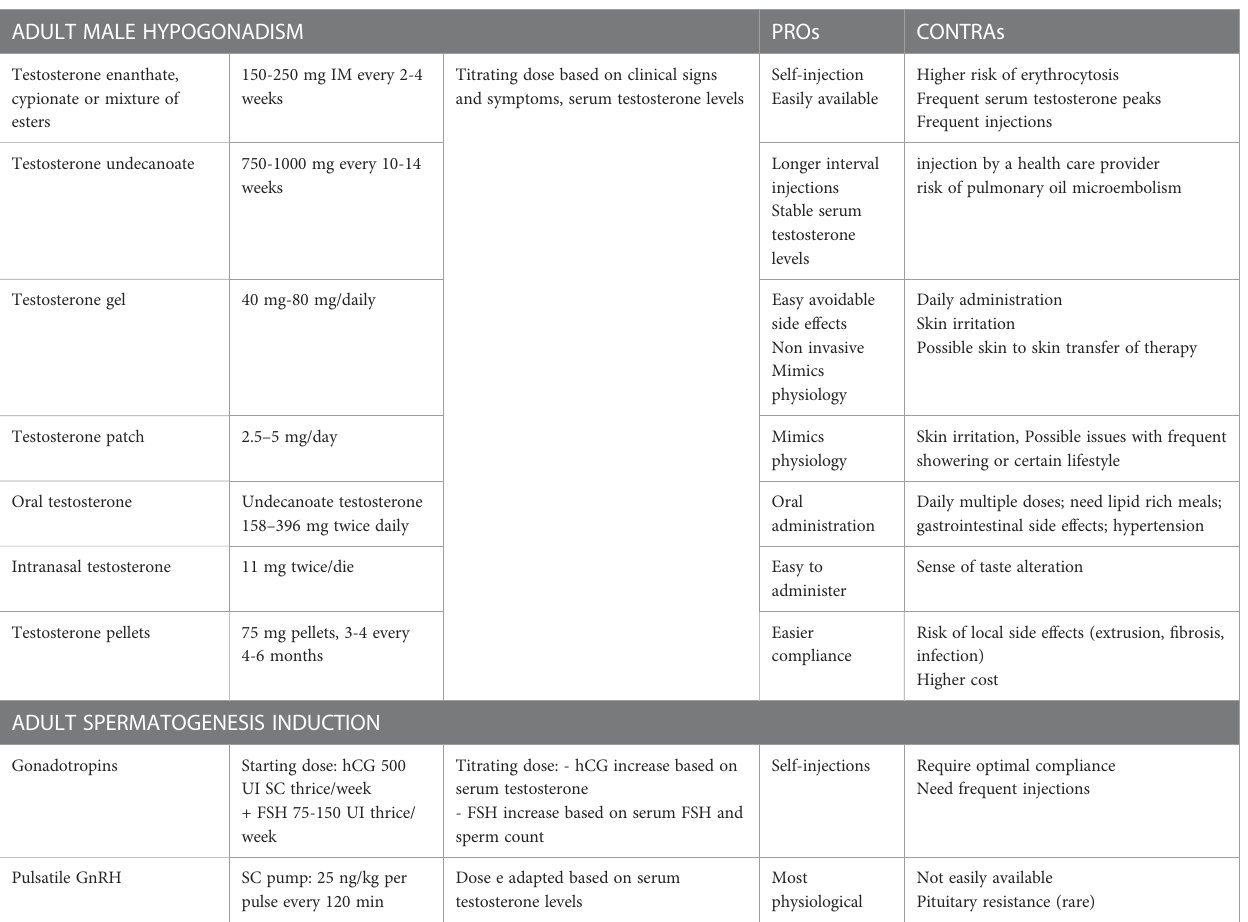
TABLE 3 Summary of treatment options in male adult affected by Isolated Hypogonadotropic